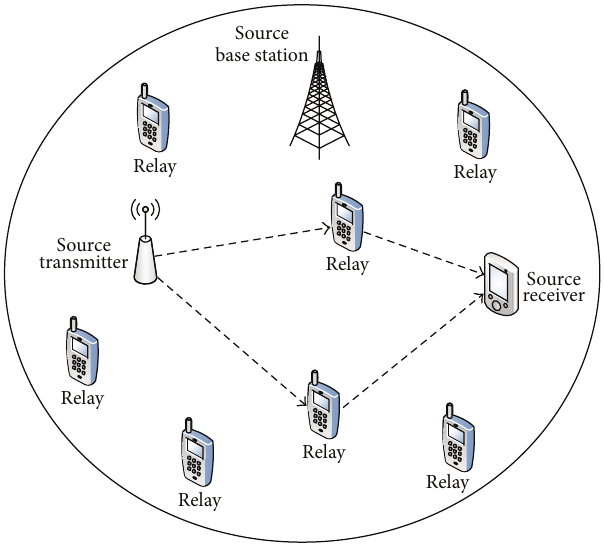
Figure 1: Wireless cooperative